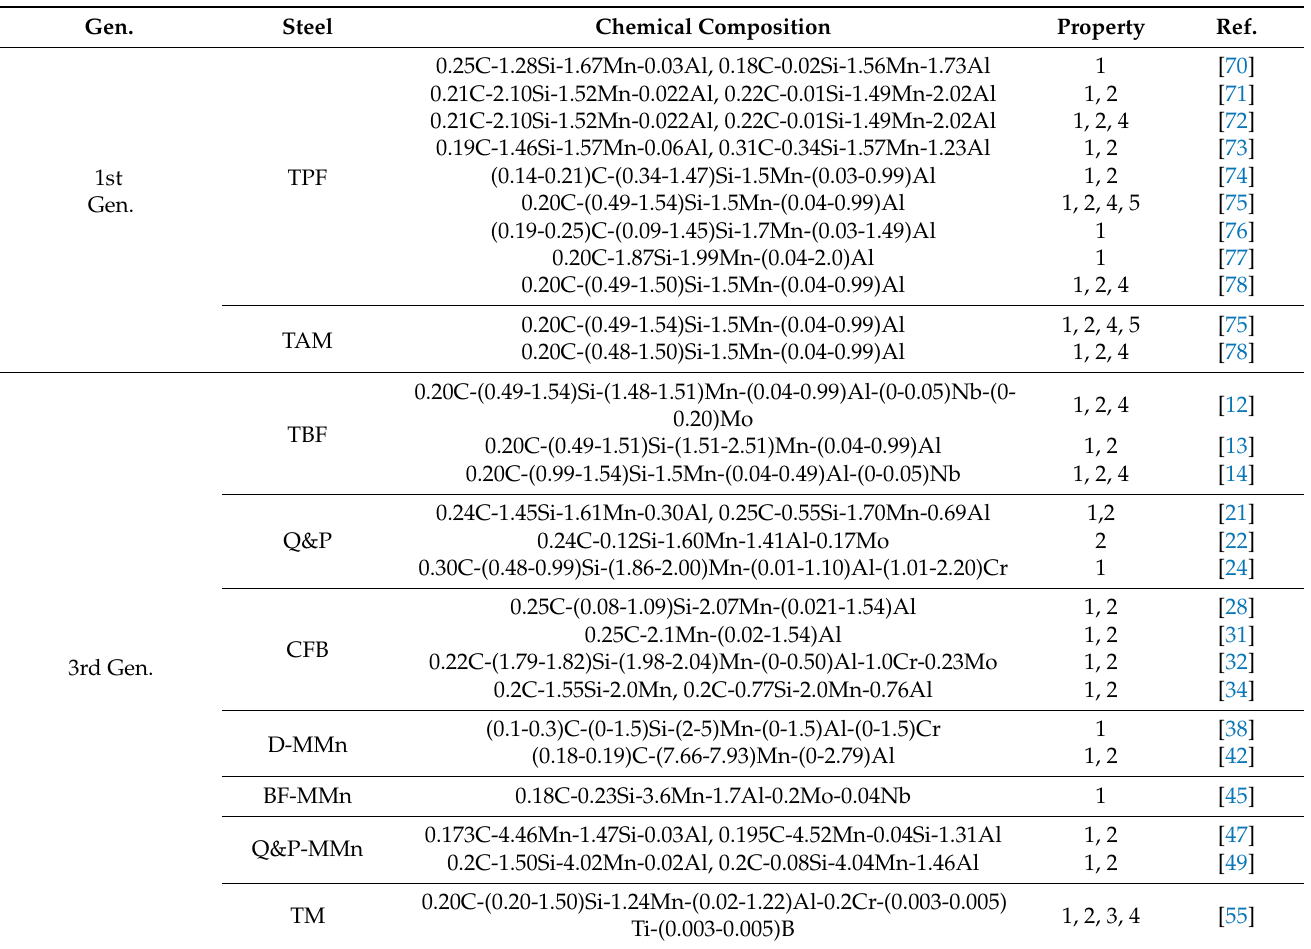
Table 1. Chemical composition (in mass%), measured properties, and references for low-carbon Si/Al-Mn first- and third-generation AHSSs used in various kinds of research. Gen. Steel Chemical Composition Property Ref.